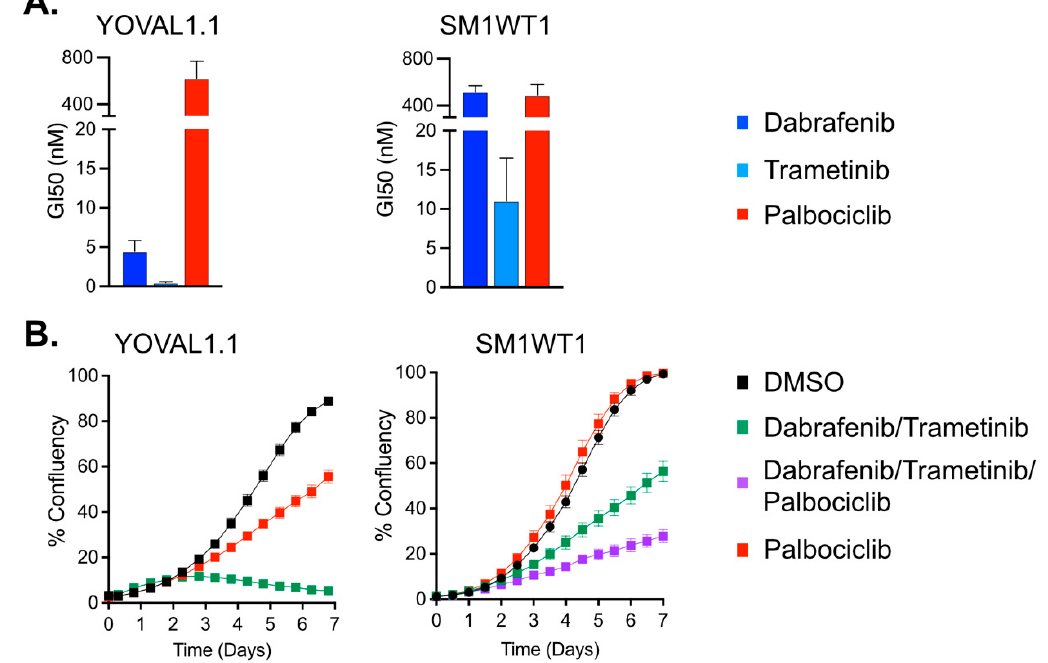
Figure 1. Sensitivity of mouse melanoma cell lines to targeted therapy. ( A ) Dose response assays were performed, and the concentration of drug required to inhibit proliferation by 50% (GI50) was determined. Bar graph represents mean ± SEM of 3–7 independent dose response experiments. For YOVAL1.1, a significant difference ( p < 0.0001) in GI50 ′ s was observed between palbociclib (623 ± 147 nM) and both dabrafenib (4.5 ± 1.3 nM) and trametinb (0.5 ± 0.1 nM). For SM1WT1, a significant difference ( p < 0.0002) in GI50 ′ s was observed between the trametinib (11.0 ± 3.2 nM) and both dabrafenib (519.0 ± 29.4 nM) and palbociclib (490 ± 52.0 nM). There was no difference in mean GI50 between the other groups within a cell line. One-way ANOVA was used to determine statistical significance. ( B ) To assess cell proliferation, cells were treated for 7 days, and percent confluency was analyzed over time using an IncuCyte. For YOVAL1.1, cells doses for dabrafenib, trametinib and palbociclib were 10 nM, 1 nM, and 2 μ M, respectively. For SM1WT1, doses were 1 μ M, 30 nM, and 1 μ M, respectively. Mean ± SEM of 5 technical replicates.